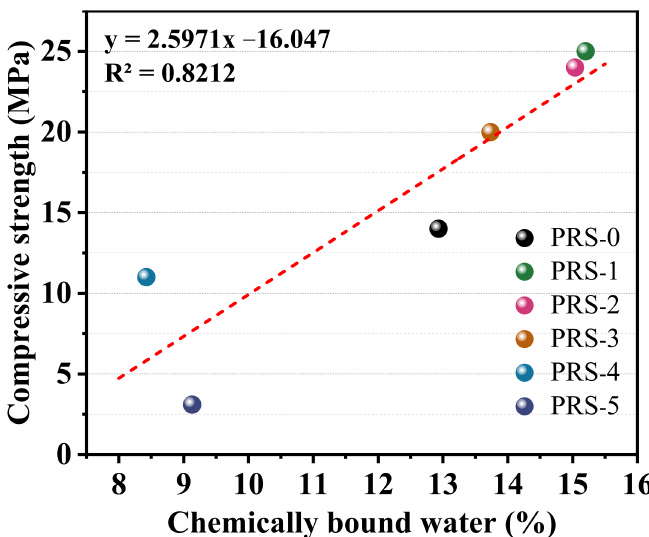
Figure 14. ( a ) TG and ( b ) DTG curves of composite cementitious materials with different phospho- gypsum contents (28 days).